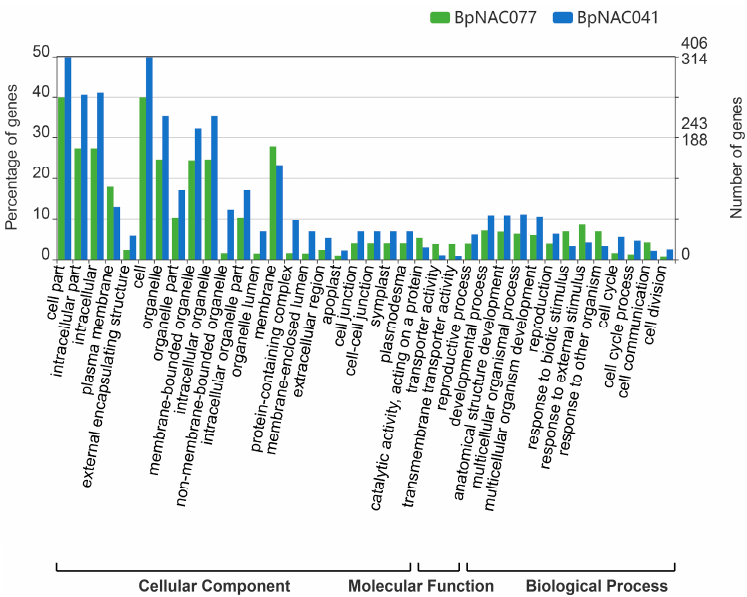
Figure 5. Statistical results of GO annotations co-expressing genes with BpNAC077 and BpNAC041 .